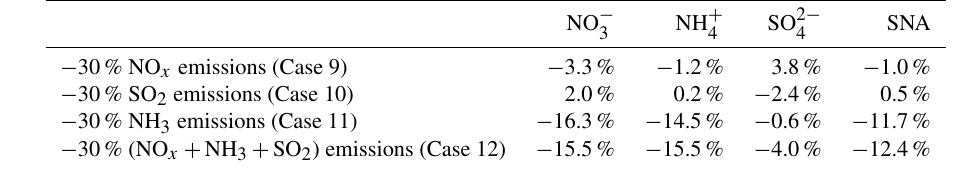
Table 4. The changed percentages of NO −